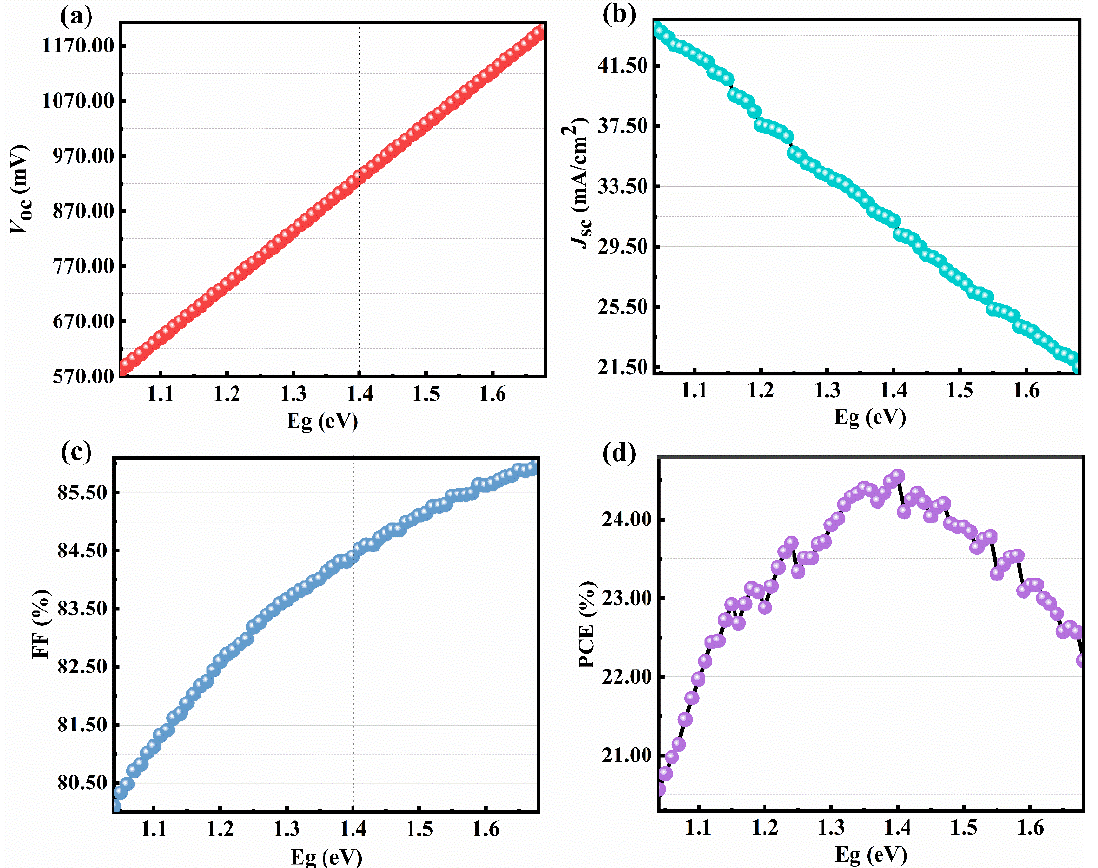
Figure 3. Dependence of ( a ) V oc , ( b ) J sc , ( c ) FF, and ( d ) PCE of CIGS solar cells on CIGS bandgap.